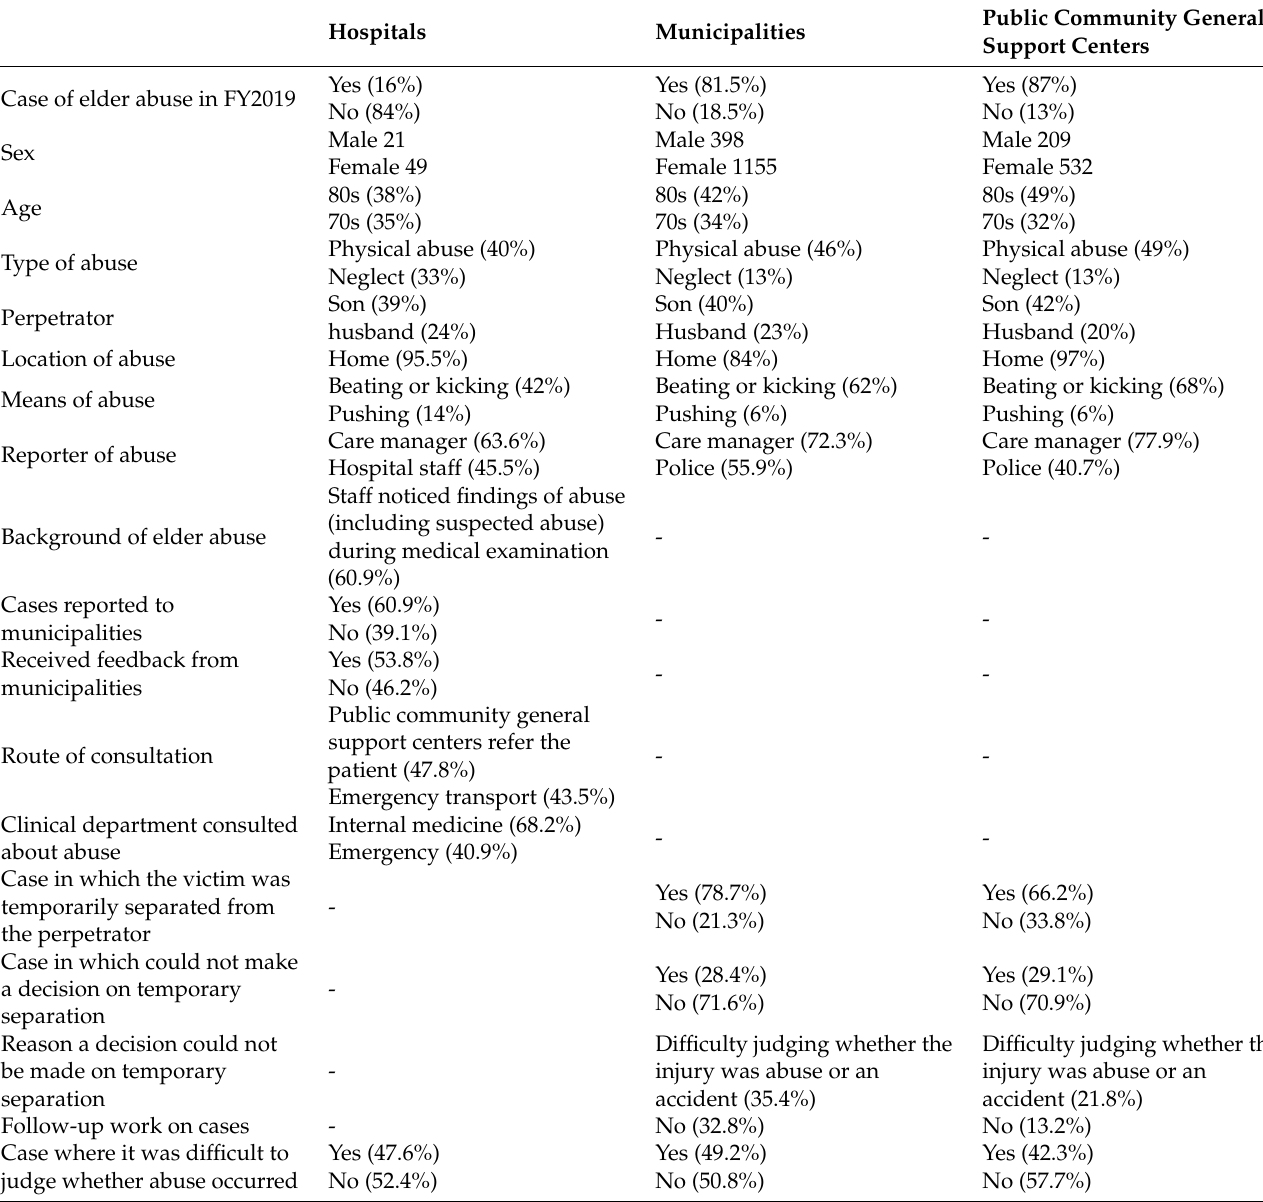
Table 3. Cases of elder abuse at related